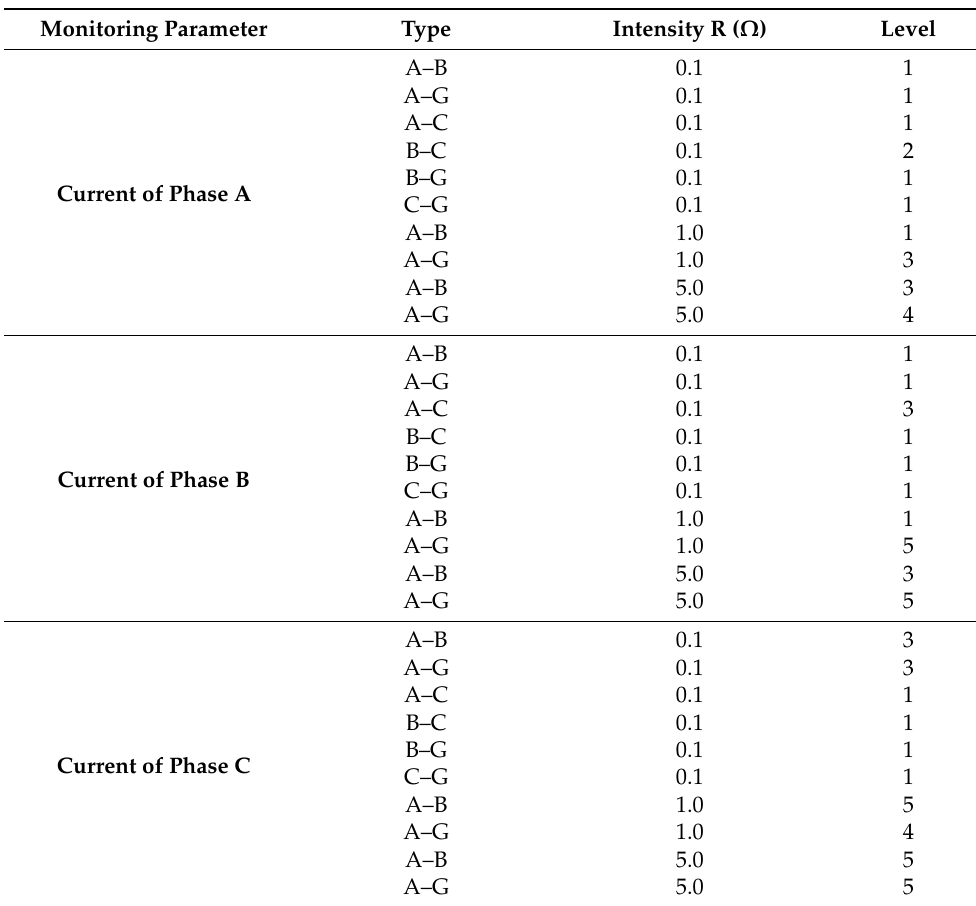
Table 5. Operation with fault at 1.4–1.7 s for the step load